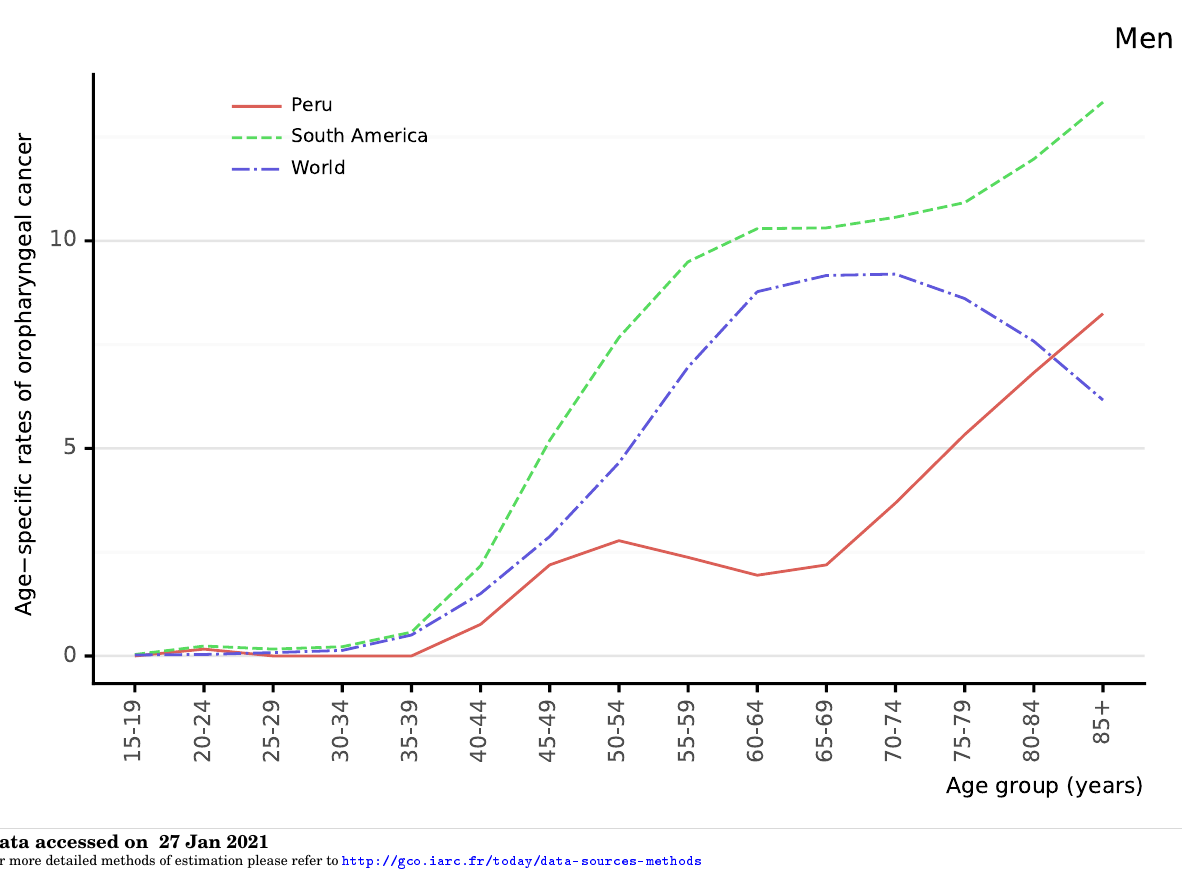
Figure 93: Comparison of age-specific oropharyngeal cancer incidence rates among men by age in Peru, within the region, and the rest of